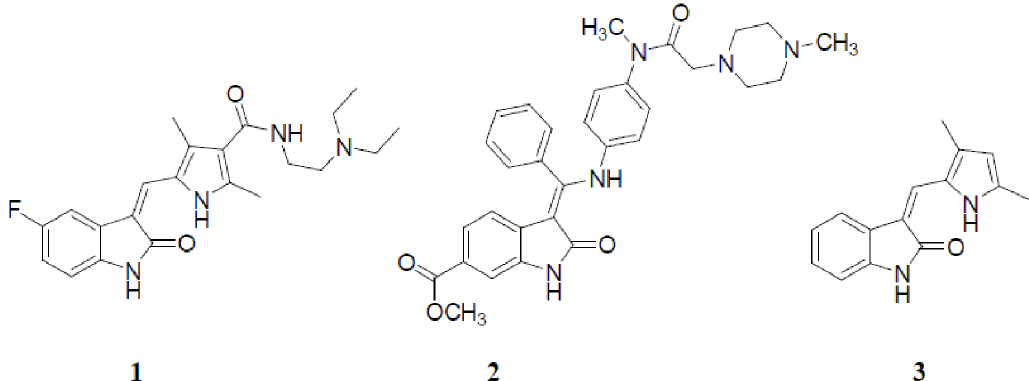
Fig 1. Chemical structuresof some clinically used isatine-based anticancer agents.